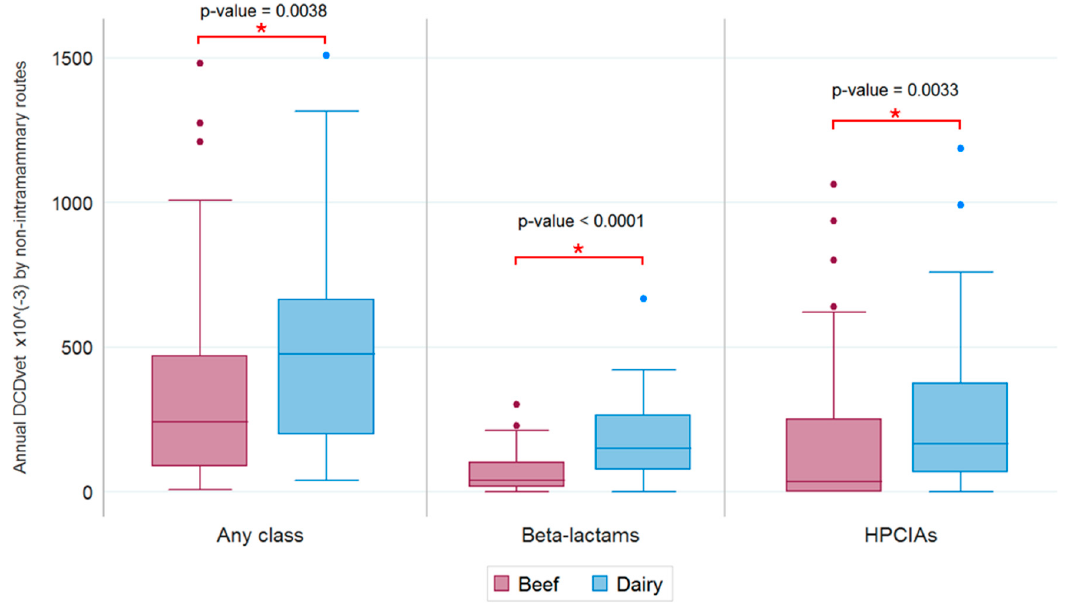
Figure 6. Annual consumption of antibiotic, beta-lactams and HPCIAs, by non-intramammary routes on beef and dairy farms respectively.